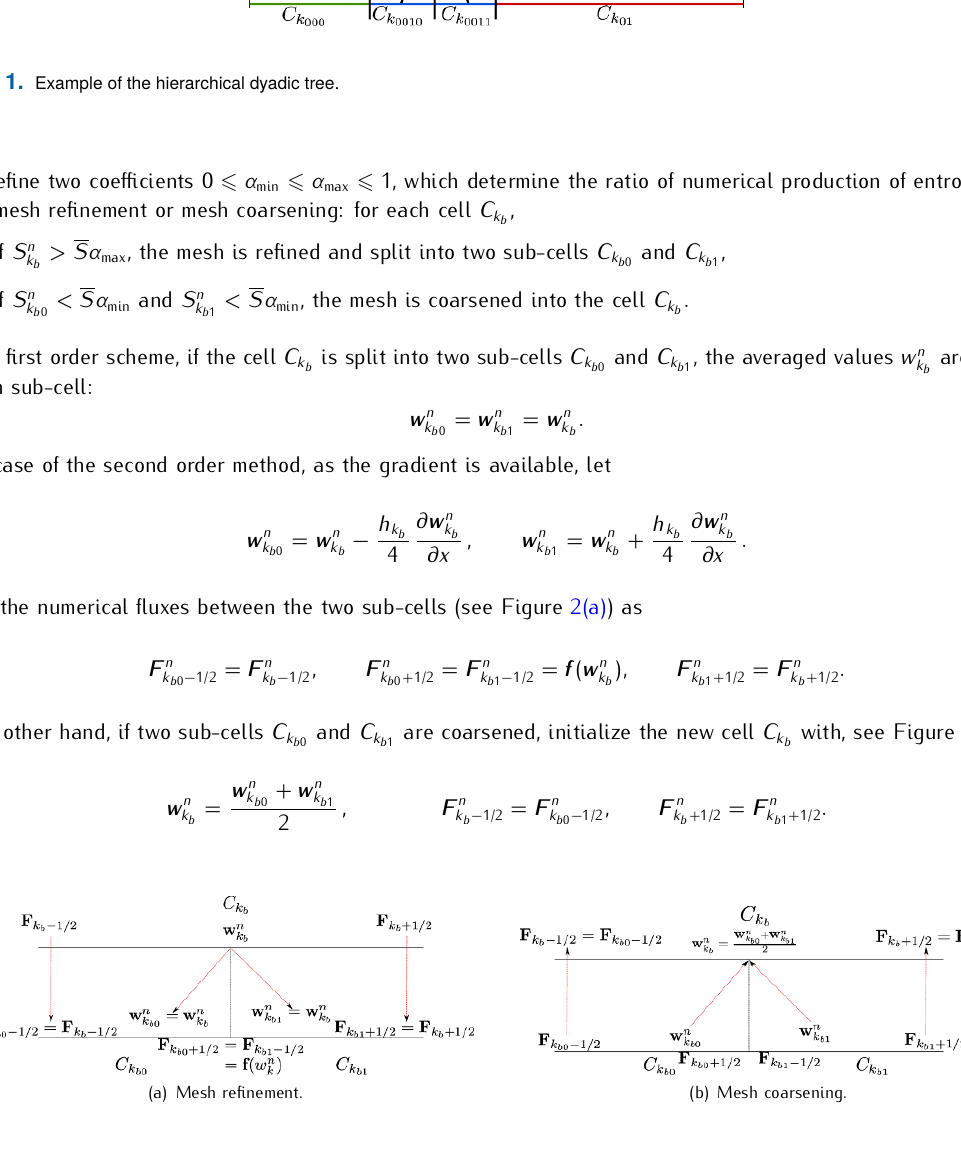
Figure 2. Mesh refinement and mesh coarsening: construction of the